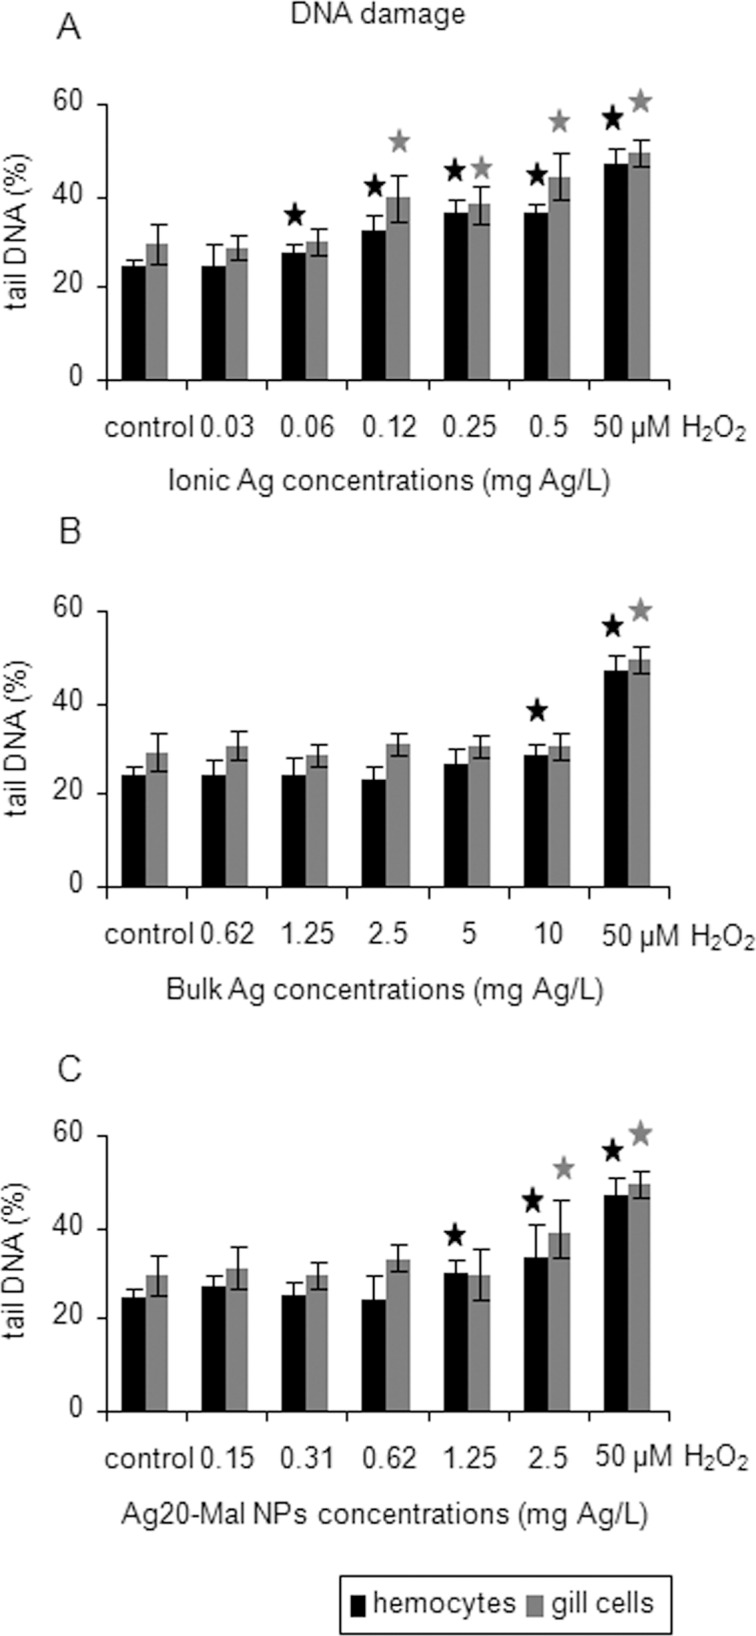
DNA damage in mussel cells exposed to ionic Ag, bulk Ag and Ag NPs.Results of the Comet assay in mussel hemocytes and gill cells exposed to ionic Ag (A), bulk Ag (B) and Ag20-Mal NPs (C) for 24 h. Data are given as arbitrary values for tail DNA (means ± confidence intervals). Cells exposed to 50 μM H2O2 were used as positive control. Stars indicate significant differences (p<0.05) in treated cells with respect to controls according to the bootstrap analysis followed by Bonferroni’s correction. n = 50 cells analyzed per treatment.